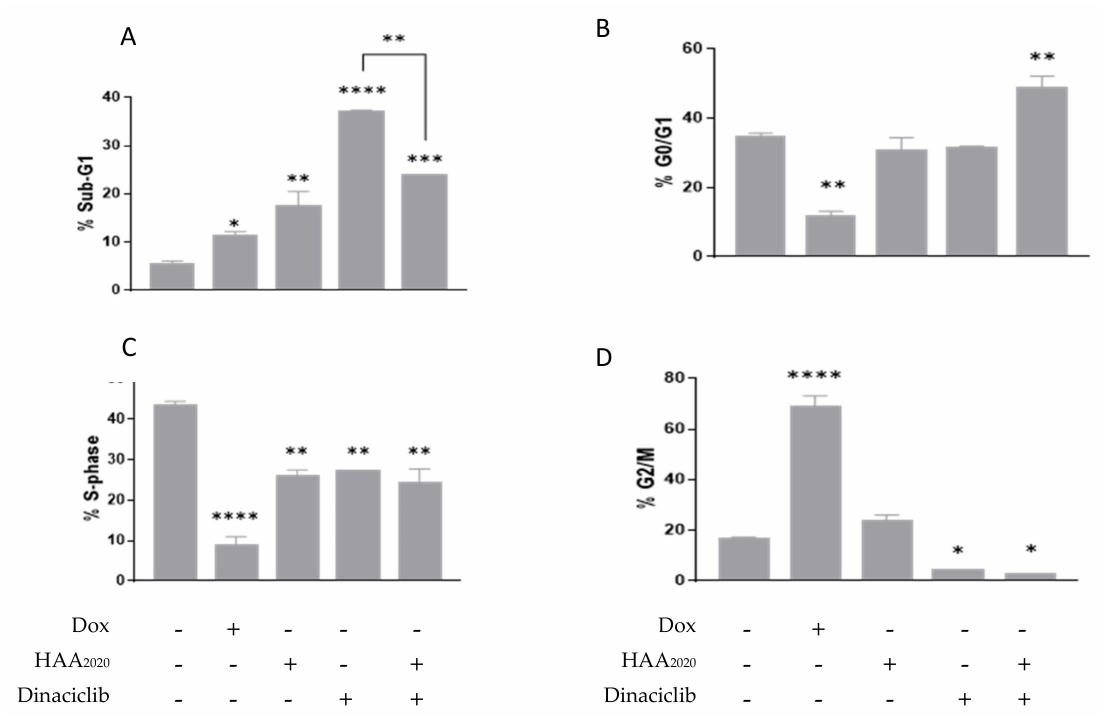
Figure 4. Cell cycle analysis in HL60 cells. Cells were treated ( + ) for 24 h with either 100 nM doxorubicin (Dox), 500 nM HAA 2020 , 10 nM dinaciclib or a combination of HAA 2020 and dinaciclib (500 nM and 10 nM, respectively). Data are represented as mean ± SEM ( n = 2, two independent experiments) for each of the phases of the cell cycle, sub-G 1 ( A ), G 0 / G 1 ( B ), S ( C ) and G 2 / M ( D ). Statistical di ff erences, compared with the untreated control cells (-), were assessed by a one-way ANOVA with the Tukey’s post-hoc multiple comparison test (GraphPad Prism). p < 0.05 (*), p < 0.01 (**), p < 0.001 (***) and p < 0.0001 (****) were taken as